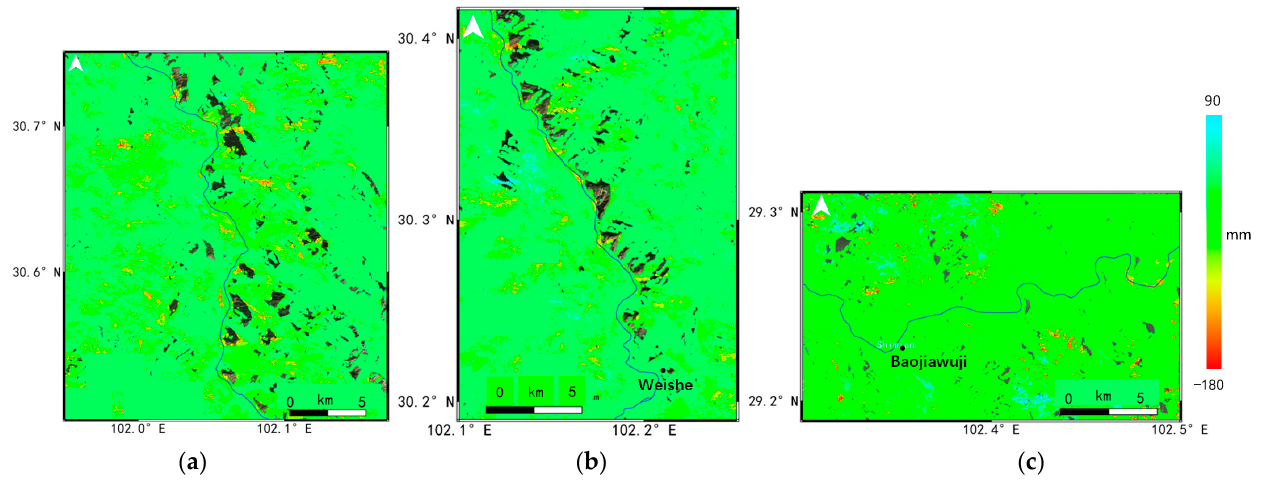
Figure 10. The displacement map for the Danba ( a ), Luding ( b ) and Shimian ( c ) Section (The blue line is the Dadu River).